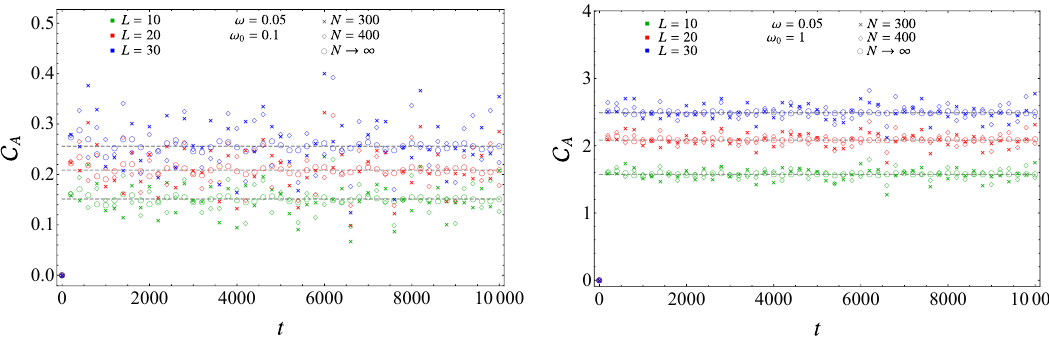
Figure 21 . Temporal evolution of C A after a global quantum quench with a gapped evolution Hamiltonian for a block made by L consecutive sites in harmonic chains either with PBC or on the infinite line. The dashed grey lines correspond to